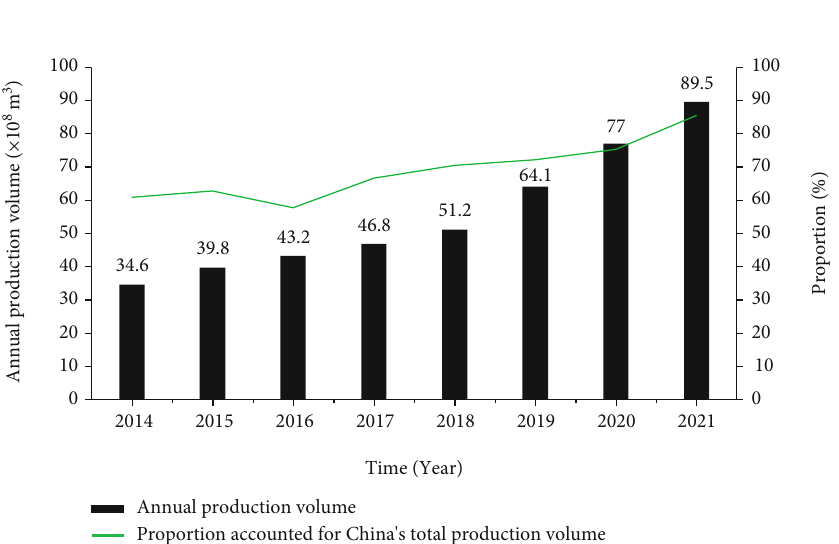
Figure 4: Annual CBM production volume in Shanxi Province